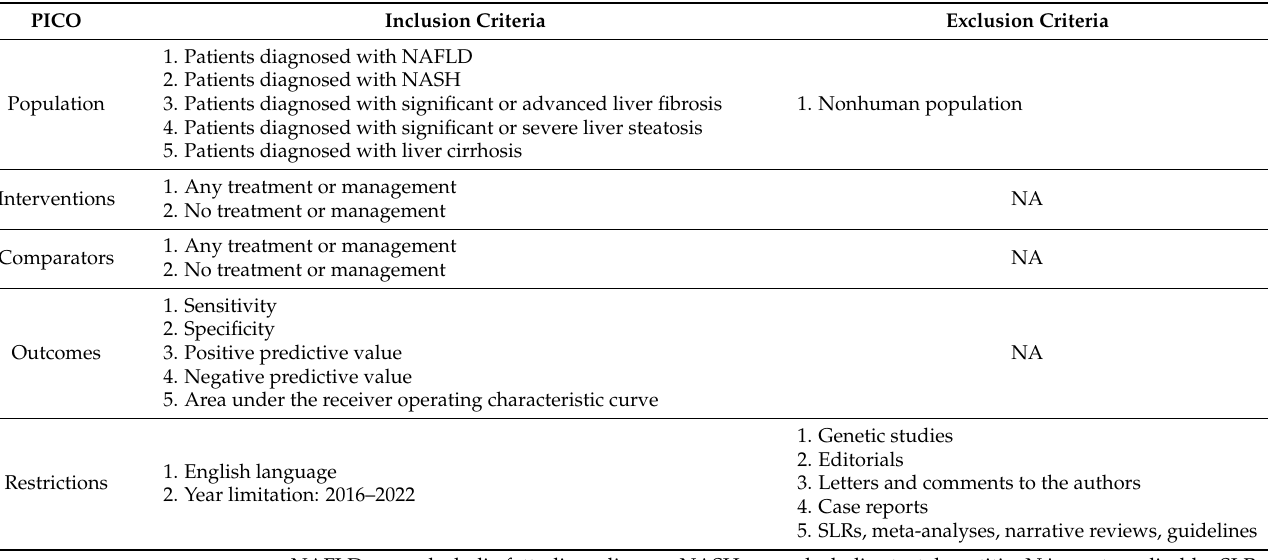
Table 2. PICO criteria for diagnostic tools